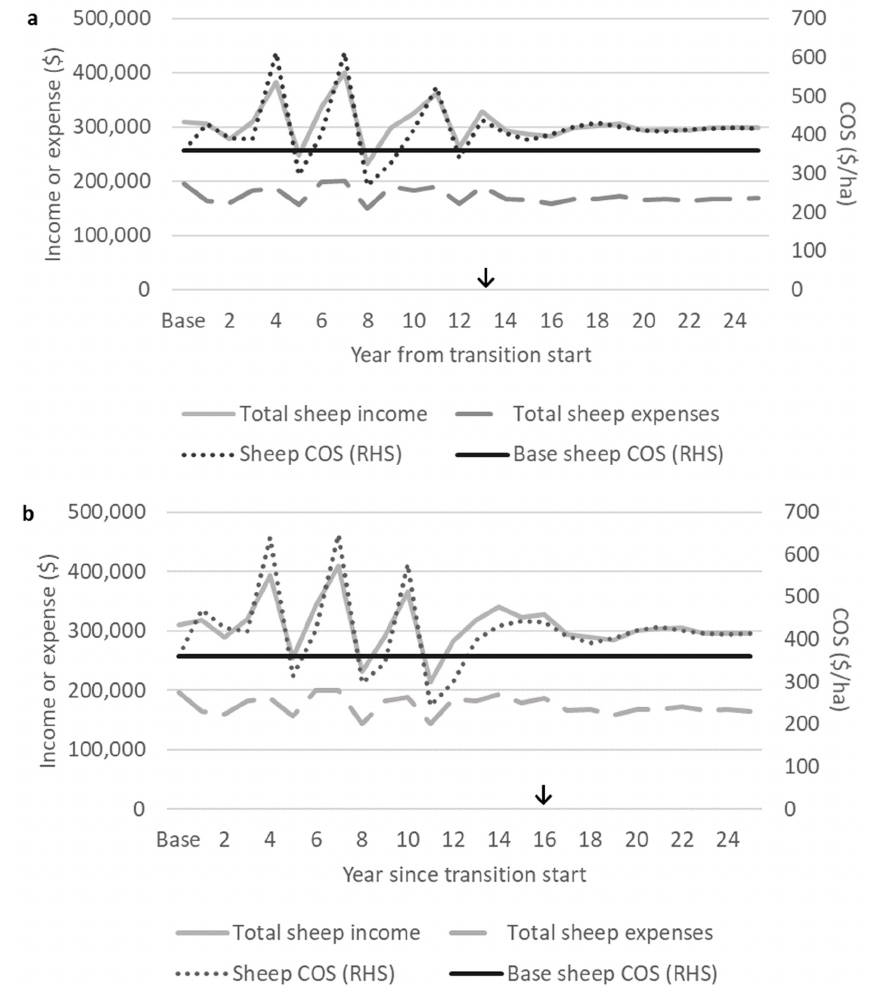
Figure 7. Total sheep enterprise income, expenses, and cash operating surplus (COS) during a grading up transition from base Romney to a desired final cross of either ( a ) ⅞ W ⅛ R or ( b ) straightbred, with the base Romney sheep enterprise COS for comparison. RHS = right hand side vertical axis. ↓ Where the grading up transition period has finished and the desired final cross flock ( ⅞ W ⅛ R or straightbred) has reached an equivalent feeddemand to the base Romney flock.